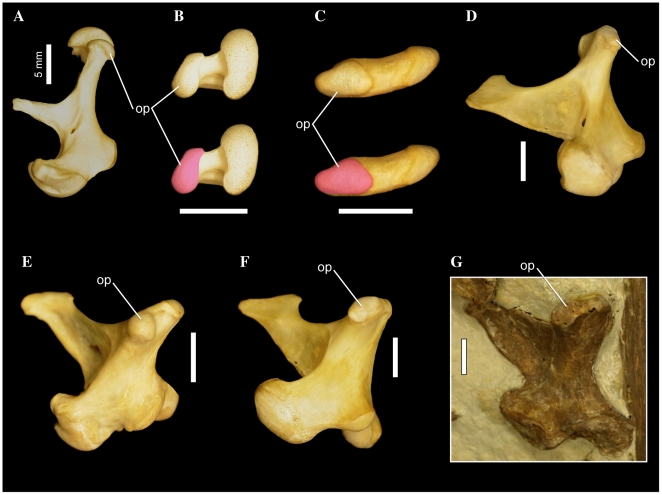
Right quadrates of several waterbird taxa.
Phalacrocorax carbo FMNH 339390 (A, B), Fregata minor FMNH 339421 (C, D, F), Phoebastria nigripes FMNH 339601 (E), and Limnofregata azygosternon FMNH PA 719 (G), in medial (A, D); dorsal (B, C); and medial/posterodorsal (E–G) aspects. In (B, C) the articular surface of the otic process of the quadrate is highlighted in magenta. Scale bars equal 5 mm. Abbreviations: op, otic process.